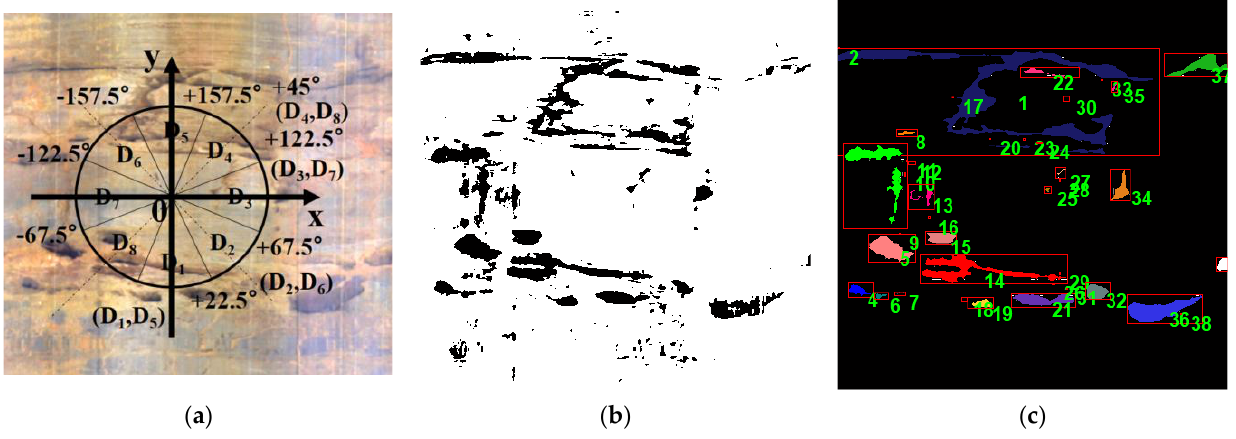
Figure 5. Identification of the pore structure in the borehole image: ( a ) azimuth interval division, ( b ) image binarization, and ( c ) pore recognition.